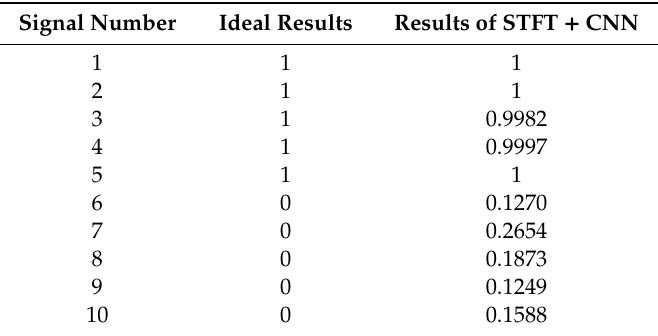
Table 5. Test results of the two